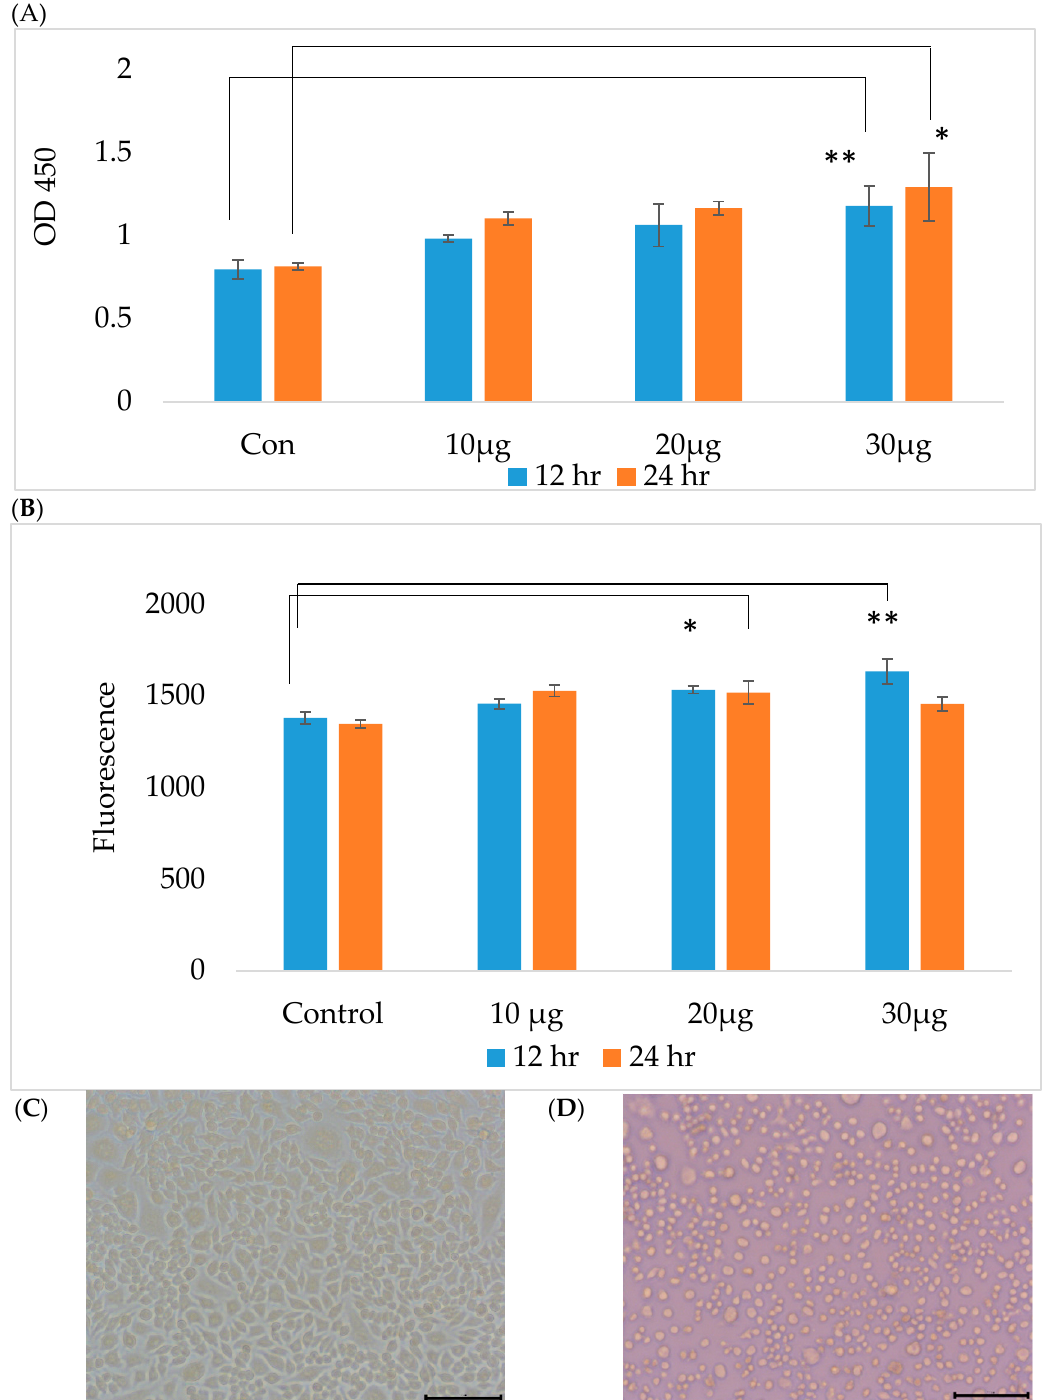
Figure 1. RAW264.7 macrophage survival and phagocytotic activity of: ( A ) The 30 μ g/mL treatment group showed significantly greater survival than the control group ( p < 0.01) at 12 and 24 h ( p < 0.05) under heat stress; ( B ) acetyl-xylogalactan treatment was able to significantly induce phagocytic ability ( p < 0.05) at 12 h under heat stress, but not at 24 h; ( C ) the RAW264.7 cells displayed an oval shape at 37 °C; ( D ) The RAW264.7 cells showed at 41 °C (the black bar was shown as 50 μ m) ( p < 0.05 was marked as *, p < 0.01 was marked as **).